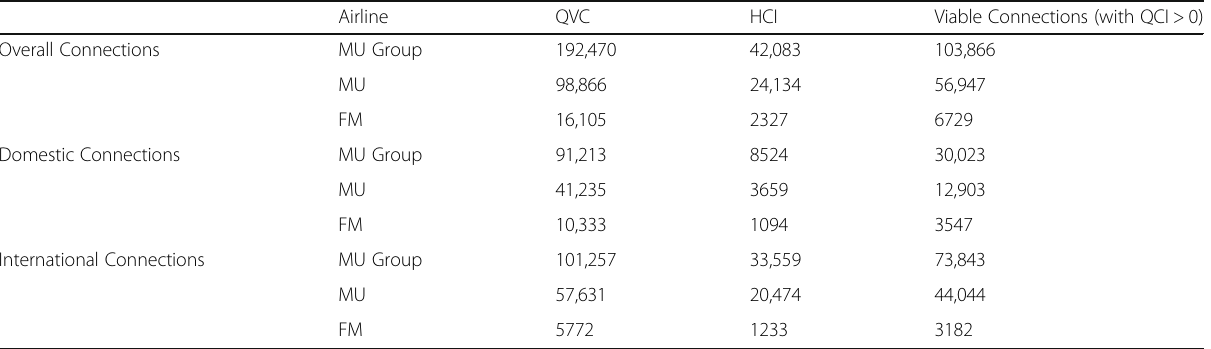
Table 2 MU Group ’ s hub connectivity